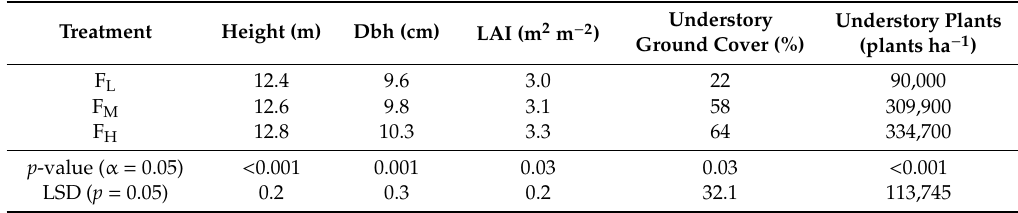
Table 1. Tree size, ground cover and diversity of understory during August 2019 (rainy season)